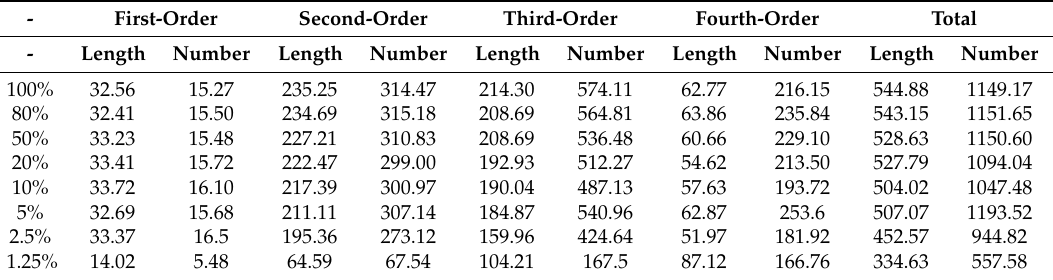
Table 3. The branch information for QSMs from down-sampling the point cloud. The TLS point cloud